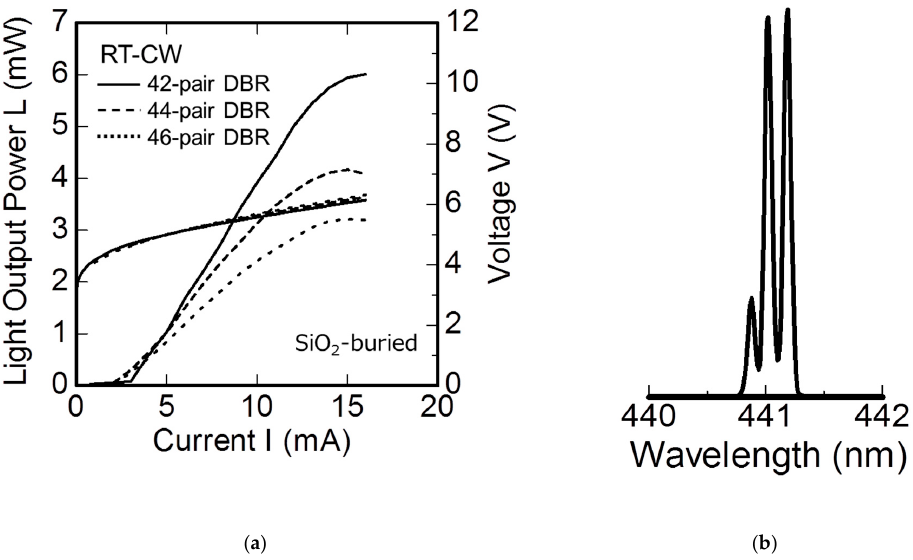
Figure 5. I-L/I-V characteristics ( a ) and emission spectrum ( b ) of the fabricated GaN-based VCSELs with 42 (solid line), 44 (dashed line), and 46 (dotted line) AlInN/GaN DBR pairs during CW operation at room temperature.